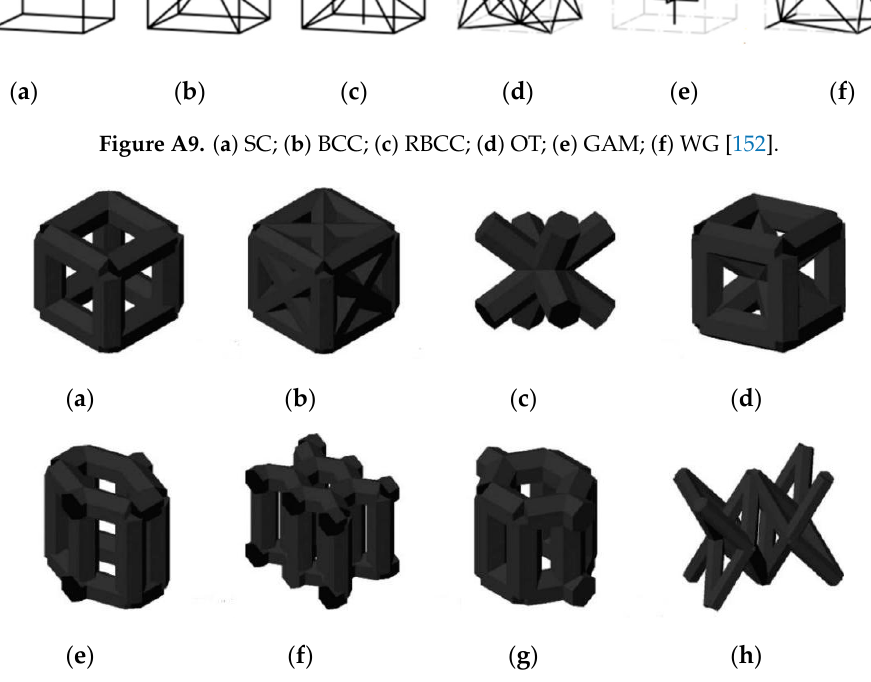
Figure A10. Rectangular prism: ( a ) C01; ( b ) C02; ( c ) C03; ( d ) C04; hexagonal structures: ( e ) H01; ( f ) H02; ( g ) H03; ( h ) H04 [153].